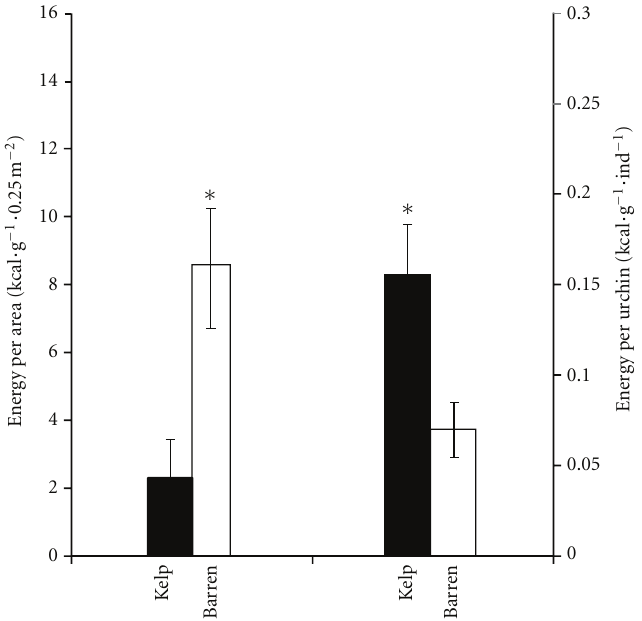
Figure 4: Sea urchin potential energy density per unit area and potential energy density per individual urchin from remnant kelp forest and urchin barren communities throughout the central and western Aleutian Islands. Significant di ff erences at P ≤ 0 . 05 level are indicated by ( ∗